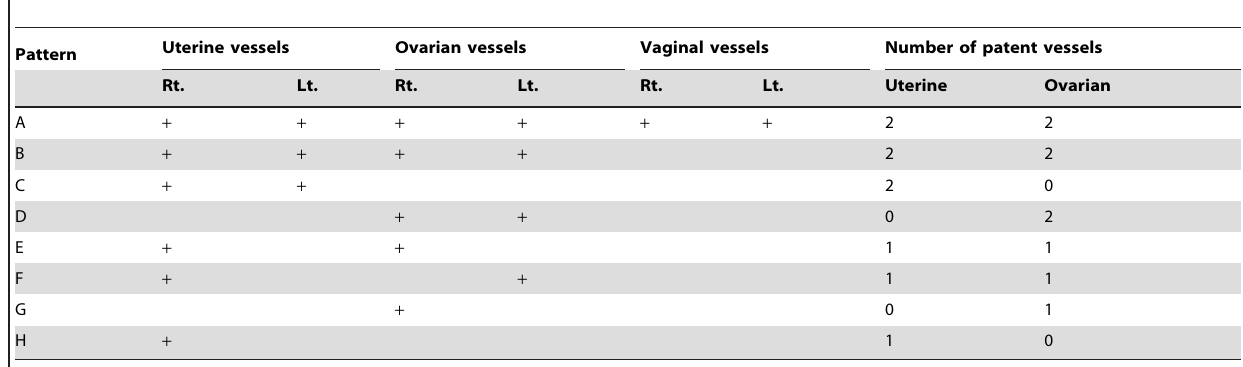
Table 1. Patterns of selected blood vessels used for uterine perfusion observed by ICG fluorescence imaging.